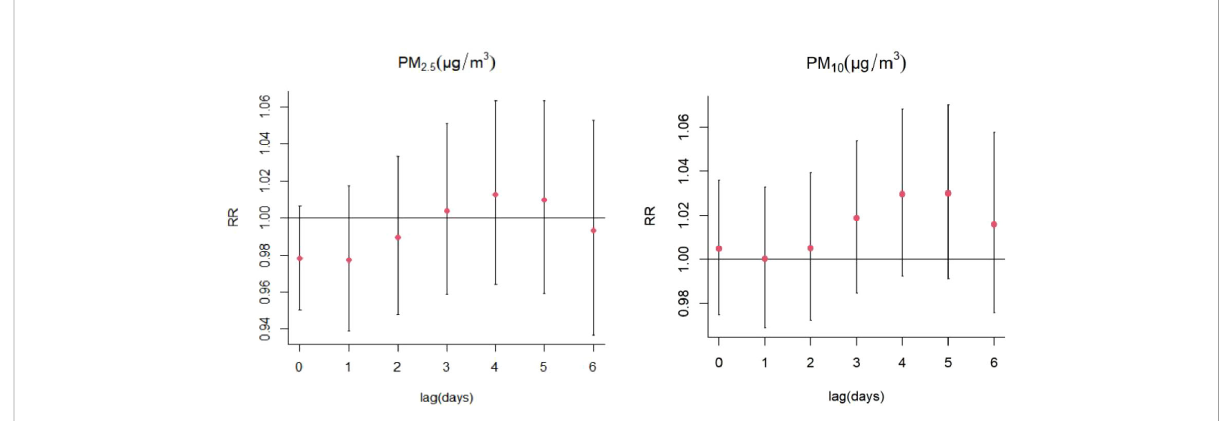
FIGURE 5 Cumulative risks (%) in hospitalizations for SS per 10 unit increase in daily mean concentrations of PM 2.5 , PM 10 .